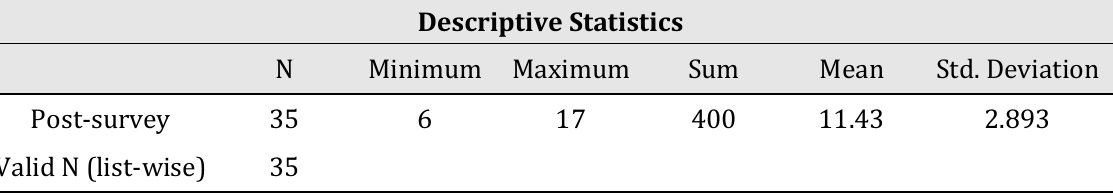
Table 20. Mean Point of Learners’ Post -survey